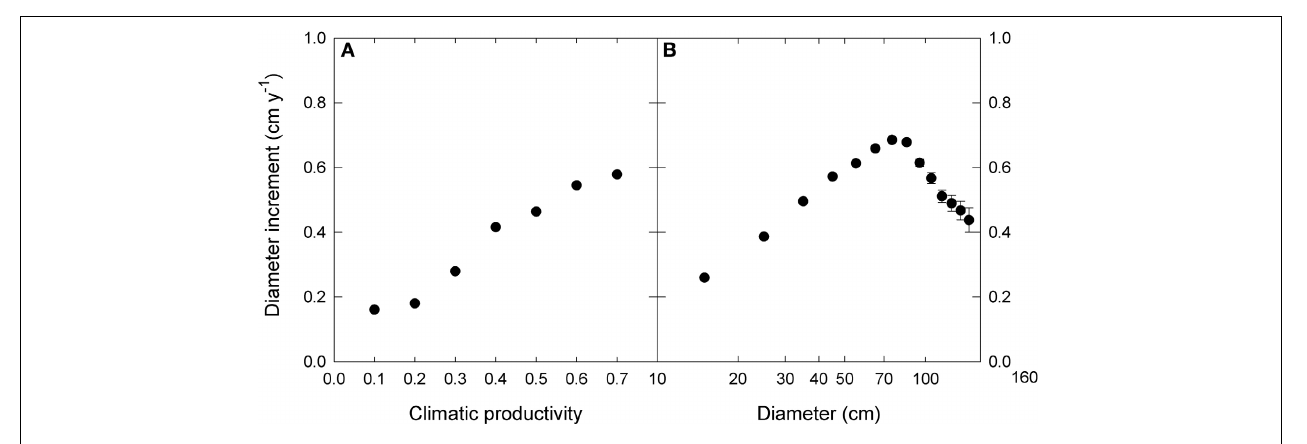
FIGURE 2 | The relationship between diameter increment and (A) climatic productivity index and (B) initial diameter. Note the logarithmic scale for diameter. For presentation, data were